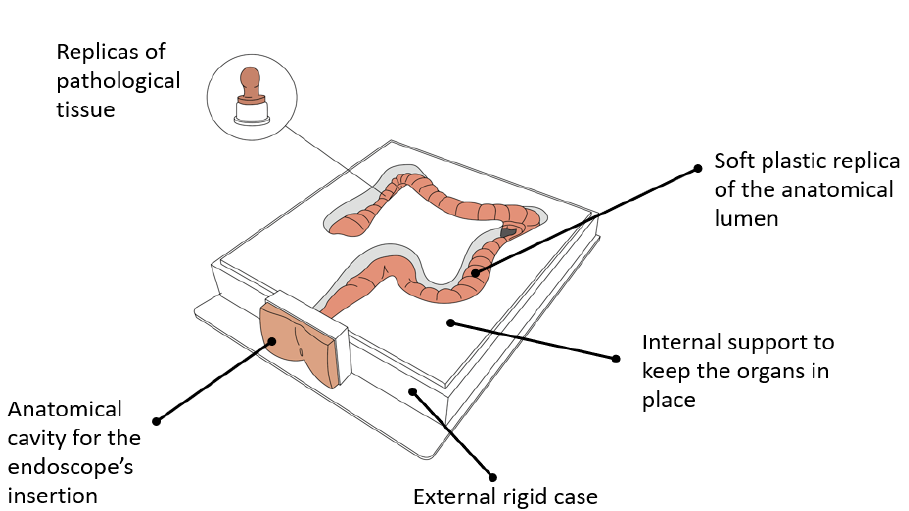
Figure 3. Mechanical simulators for GI endoscopy: main components.